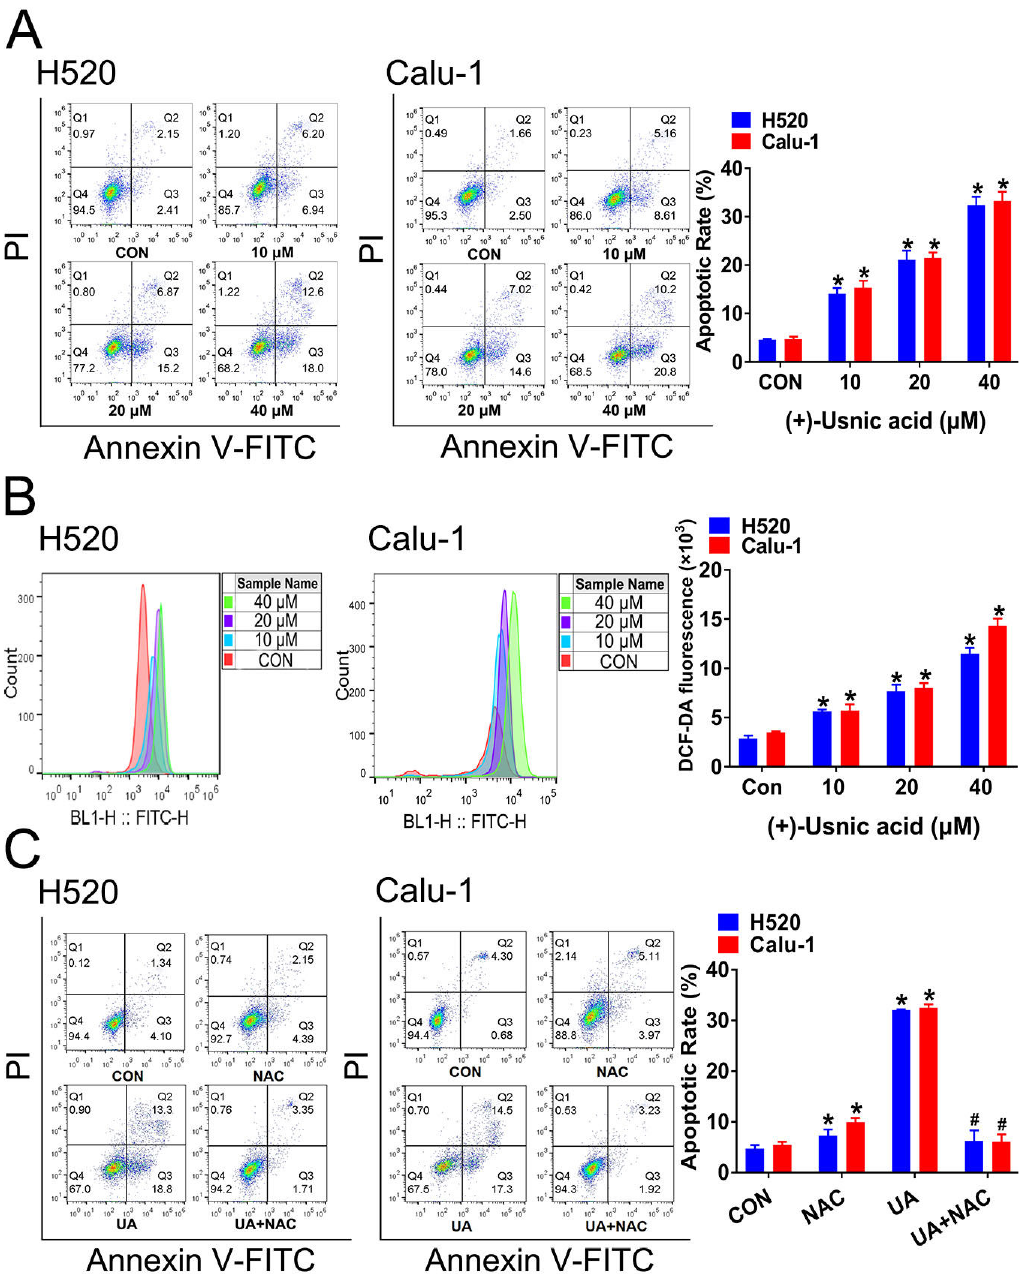
Figure 2. ( + )-Usnic acid (UA) induces cell apoptosis via cellular ROS accumulation. ( A ) The e ff ect of UA (10 to 40 µ M) treatment for 24 h on apoptosis of H520 and Calu-1 cells. Significantly di ff erent from control group, * p < 0.05, n = 3. ( B ) The e ff ect of UA at the indicated concentrations on ROS production in H520 and Calu-1 cells. Significantly di ff erent from control group, * p < 0.05, n = 3. ( C ) Administration of NAC (25 mM) e ffi ciently reserved the e ff ect of UA on cell apoptosis determined by flow cytometry. Significantly di ff erent from control group, * p < 0.05, n = 3; # significantly di ff erent from the group of UA, p < 0.05, n =